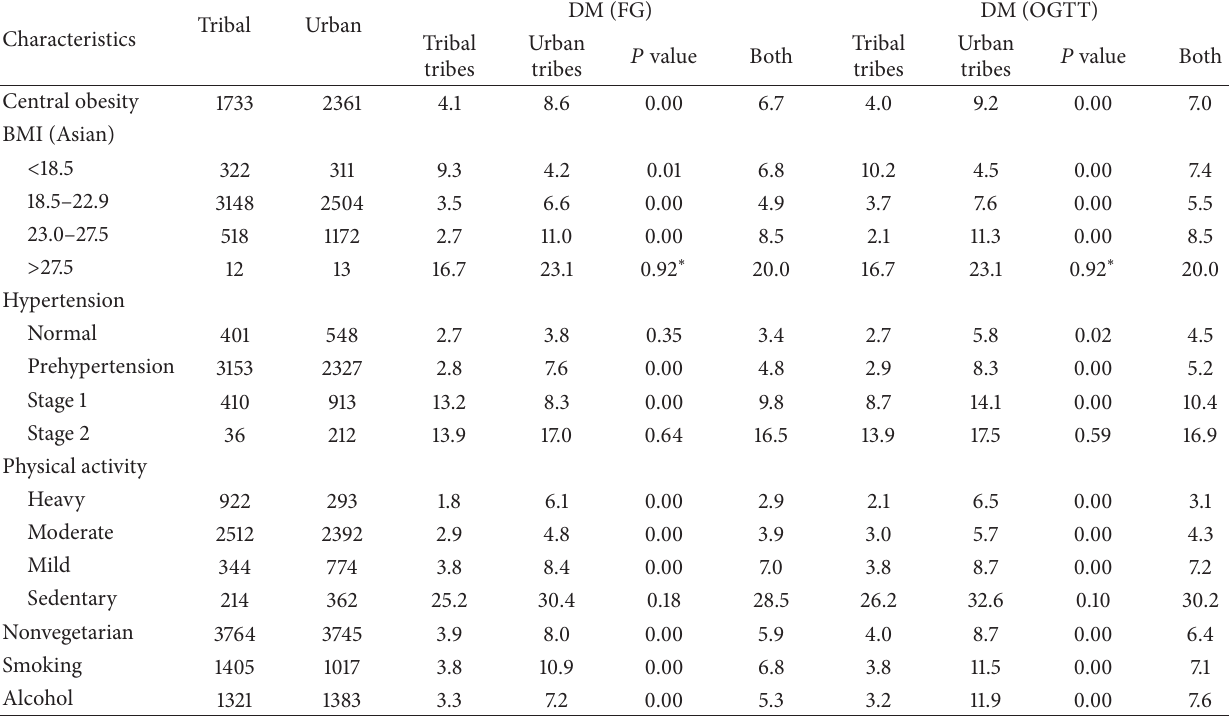
Table 7: Prevalence of DM among tribes exposed to overweight, hypertension, physical activity, diet, and substance abuse in tribal and urban areas of Himachal Pradesh,